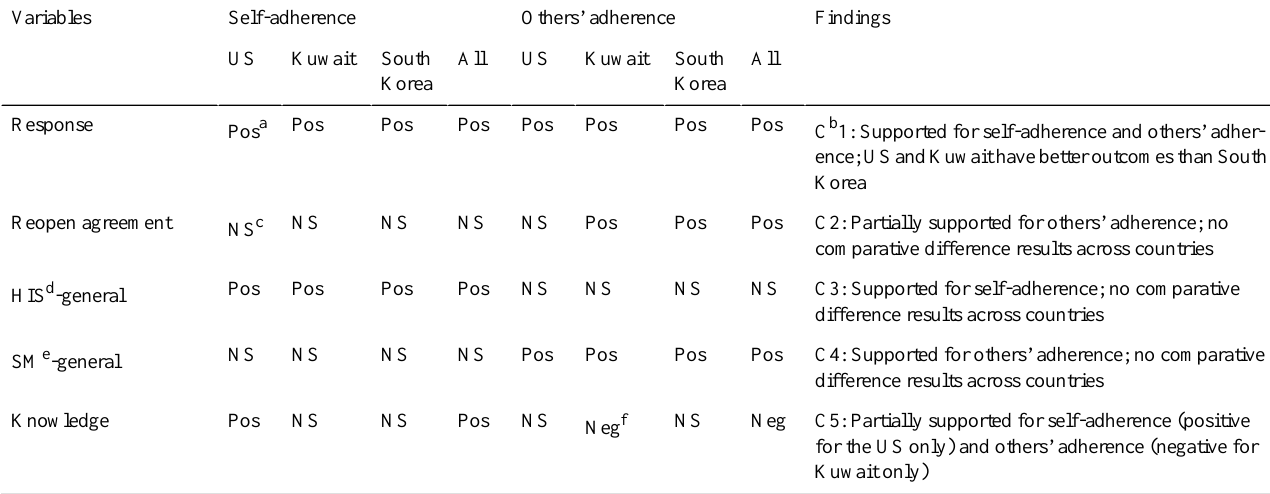
Table 4. Summary of